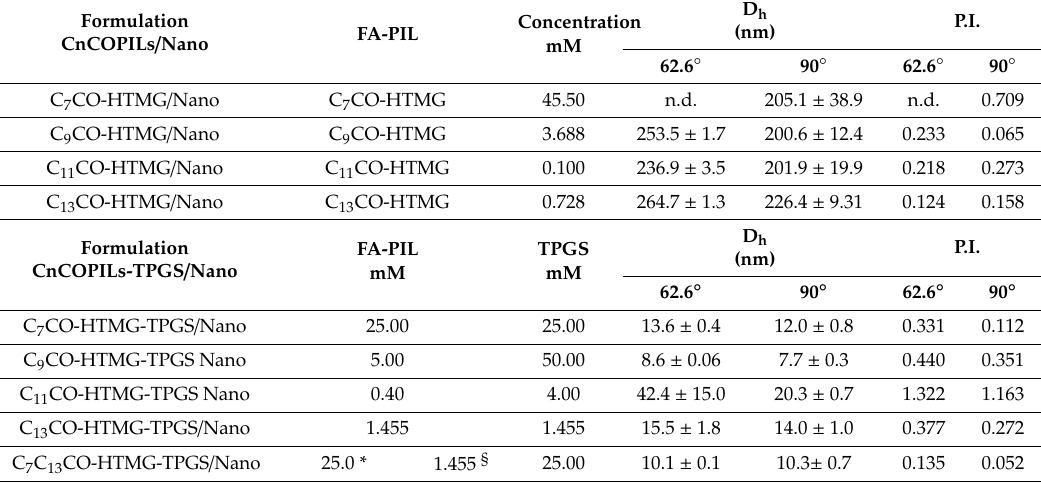
* related to C 7 CO-HTMG; § related to C 13